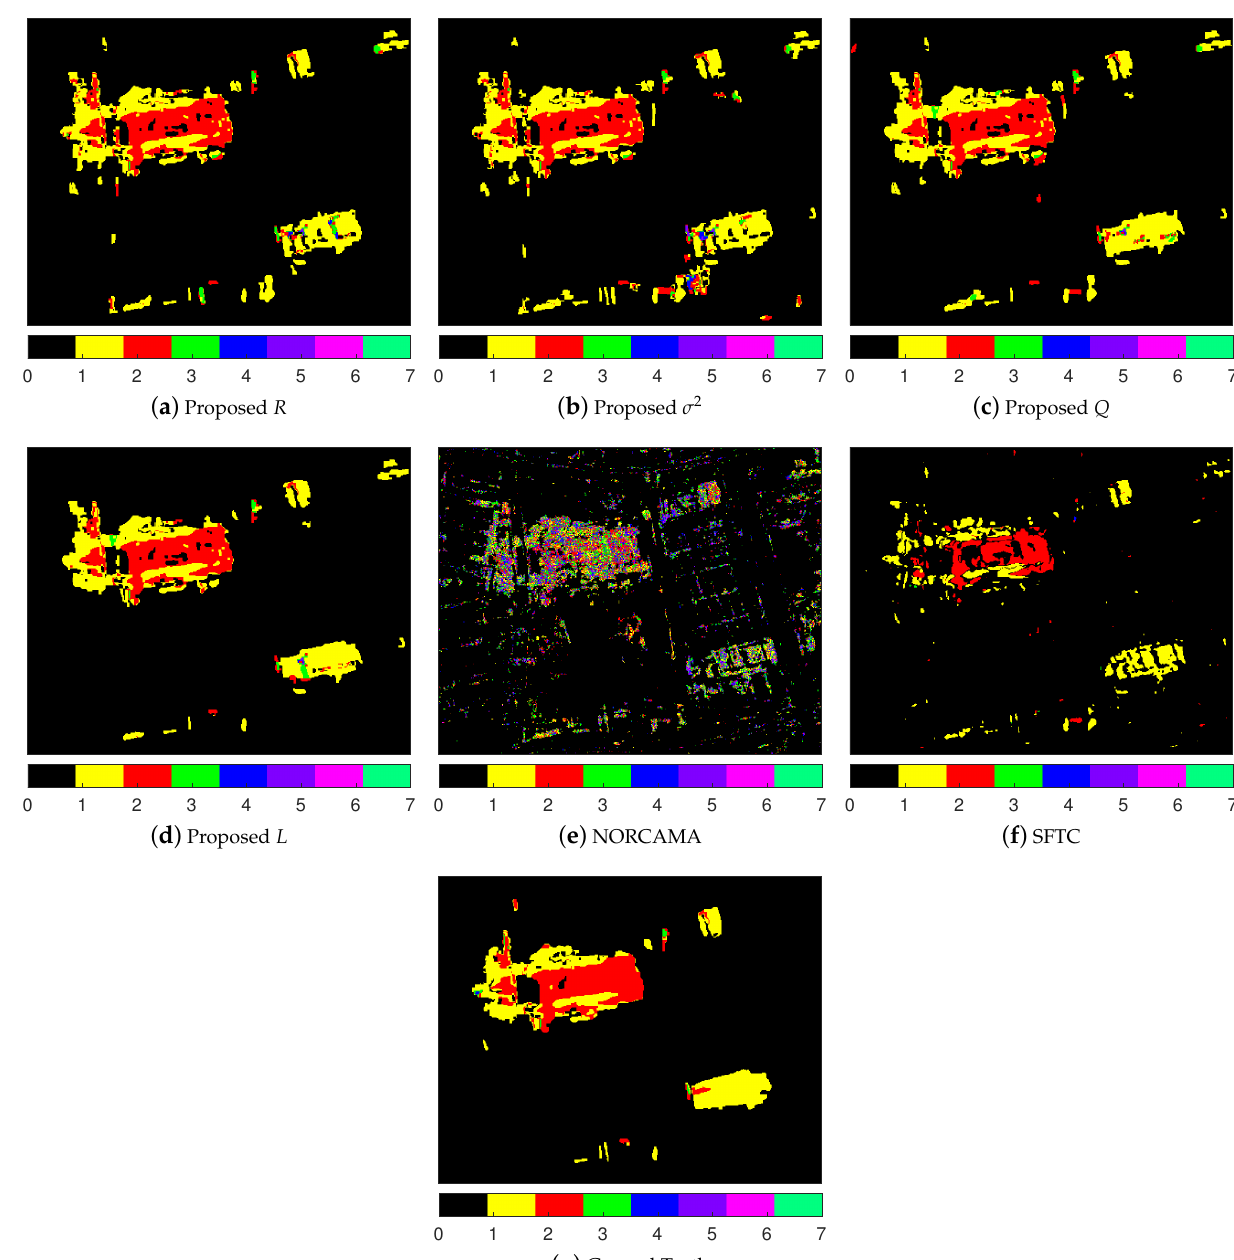
Figure 9. CFM of different methods using data